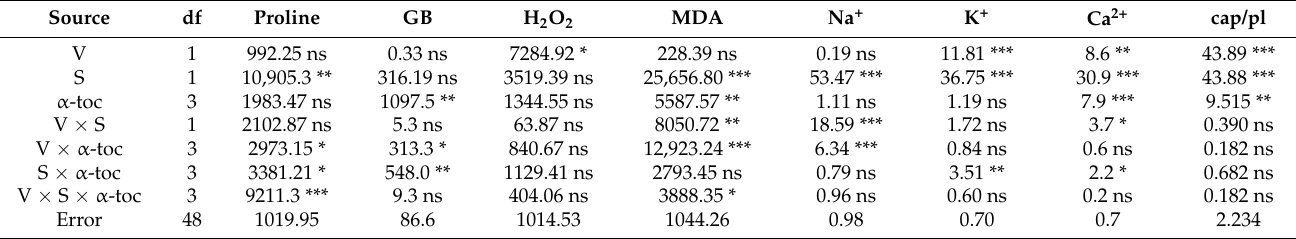
Table 2. Analysis of variance (mean squares) for osmolytes, ROS, ionic traits and yield of okra treated with α -Toc as foliar spray under saline and non-saline